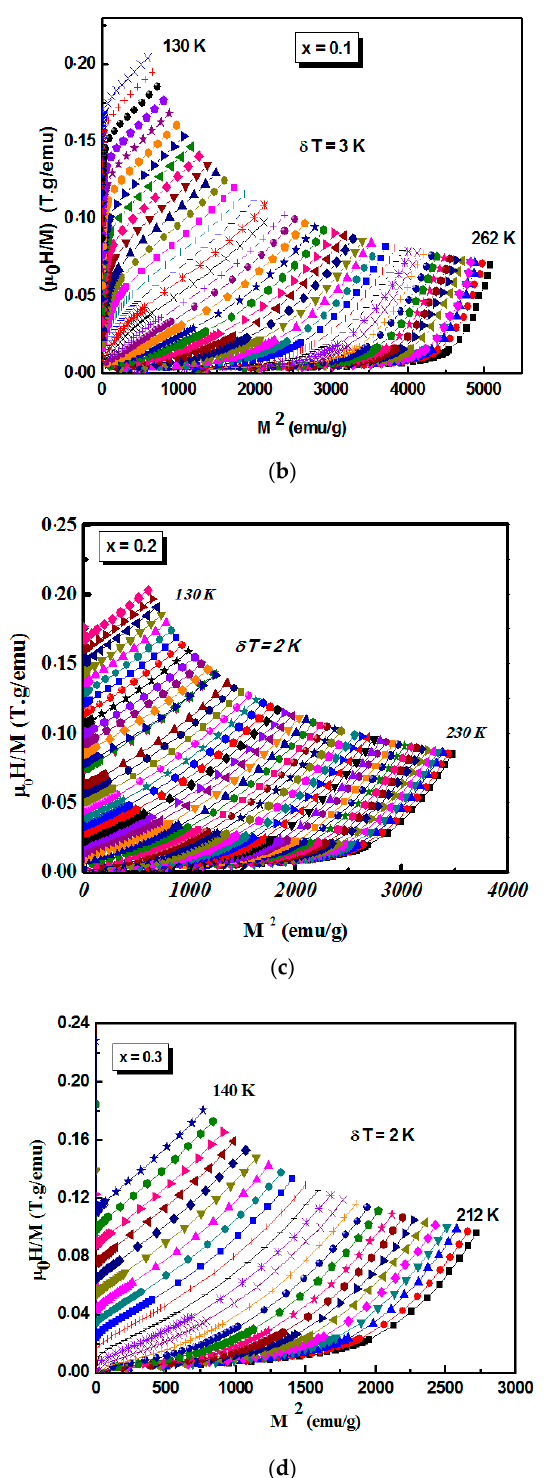
Figure 4. Arrott plots H/M vs. M 2 plot for La 0.8 Ca 0.2 Mn 1 − x Co x O 3 . ( a ) x = 0; ( b ) x = 0.1; ( c ) x = 0.2; and ( d ) x = 0.3.